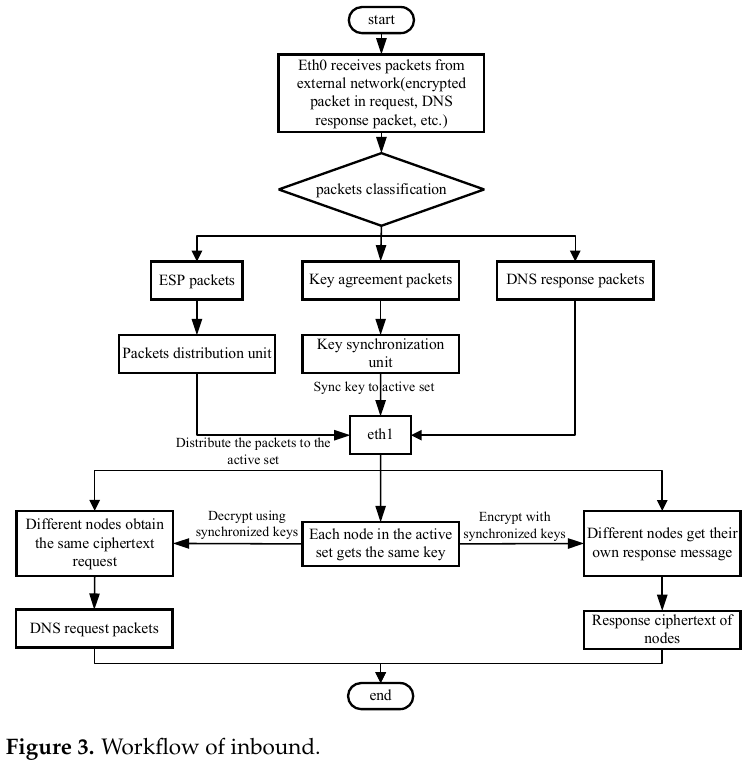
Figure 3. Workflow of inbound.